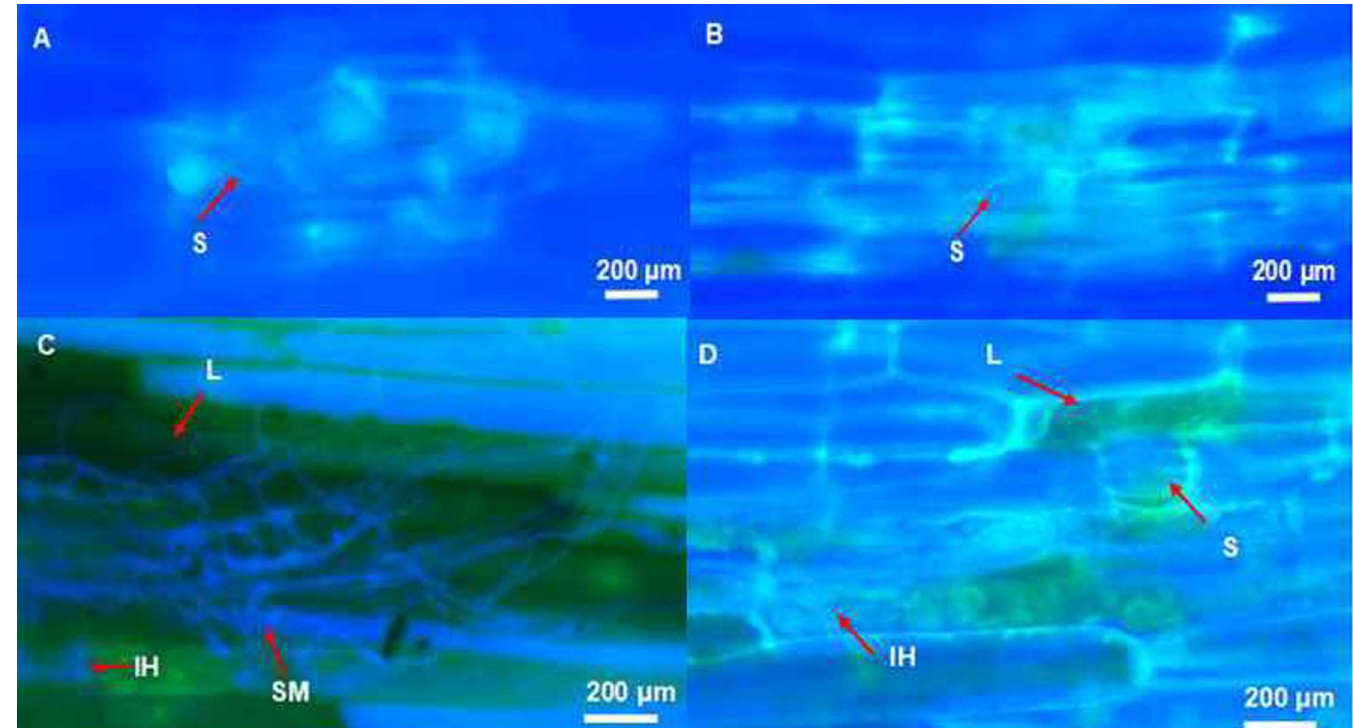
Fig 3. The infection and colonization of barley coleoptile by Fusarium pseudograminearum A: Small amounts of hyphaeemergingfrom stomata and re-invadingthe surroundingepidermis cells at 3 dpi in the drought-stressed genotypeFleet. B: Intracellular invasivehyphae growingin epidermiscell adjacent to stomata at 3 dpi in the well-watered genotypeFleet. C: Surface mycelium growingthrough heavily infected tissue at 7 dpi in the drought-stressed genotypeFranklin. D: Intracellularhyphaegrowingwithin epidermalcells at 7 dpi in the well-watered genotypeFranklin. (Tissues were stainedusing Fluorescent brightener28 and viewedunder ultravioletlight.) S: stomata; L: lesion; IH: intracellular hyphae;SM: surface mycelium.